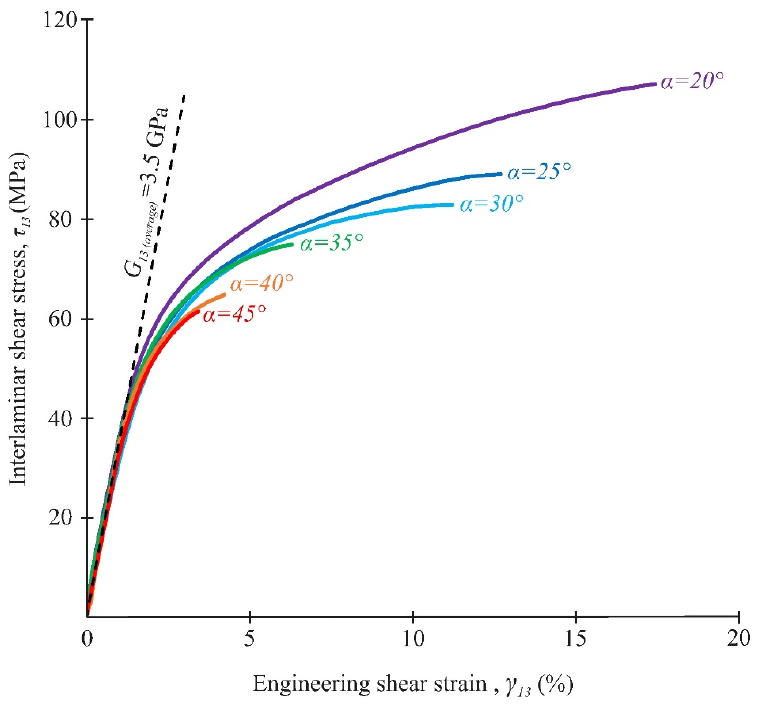
Figure 15. Shear stress–strain curves under combined compression/shear loading.